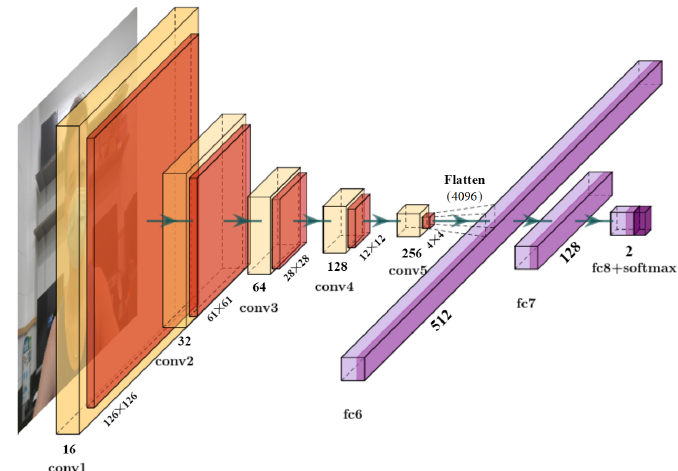
Figure 2. Illustration of proposed MaskDetect, which consists of five convolutional layers. The output feature map’s spatial dimensions and number of generated feature maps are shown to the side of and below each layer, respectively. Each conv. layer uses standard nonlinear activation function ReLU, followed by maxpooling operation with kernel size of 2 × 2. At the top, there are two fully sequentially connected layers. The final layer is two-way output with softmax.